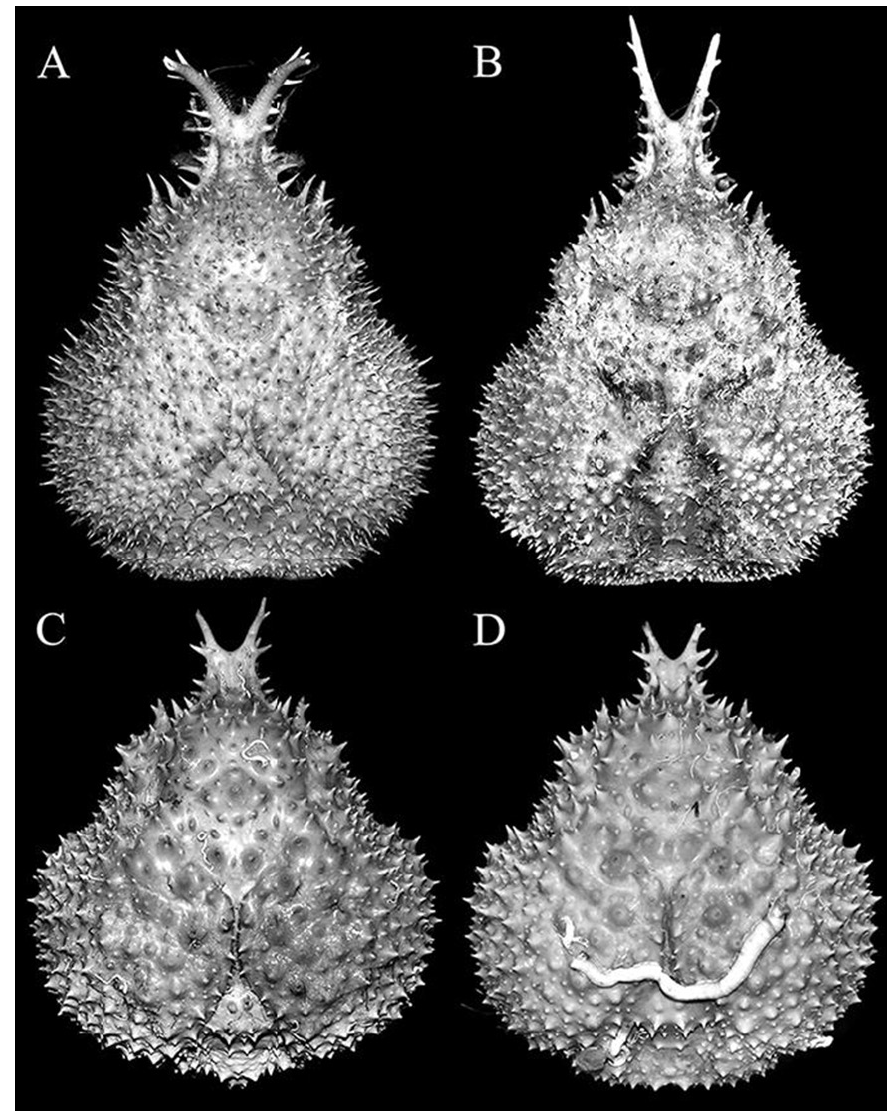
Figure 4. A Pleistacantha moseleyi (Miers, 1885), male (cl 82.5 mm, cw 61.6 mm) (ZRC 2005.117), Philippines B Pleistacantha pungens (Wood-Mason, in Wood-Mason & Alcock, 1891), male (cl 94.0 mm, cw 67.6 mm) (ZRC 2016.23), Myanmar C Pleistacantha pungens (Wood-Mason, in Wood-Mason & Alcock, 1891) C Pleistacantha kannu sp. n., holotype male (cl 106.2 mm, cw 87.0 mm) (CASAU), India D Pleistacantha kannu sp. n., paratype ovigerous female (cl 91.3 mm, cw 75.5 mm) (DABFUK), India. overlapping opposite region, regions separated by narrow longitudinal channel; cardiac region not prominently swollen, with two rows of six short spines in total; intestinal region not well demarcated, region appears depressed (Figs 2A, 4C, 5C).